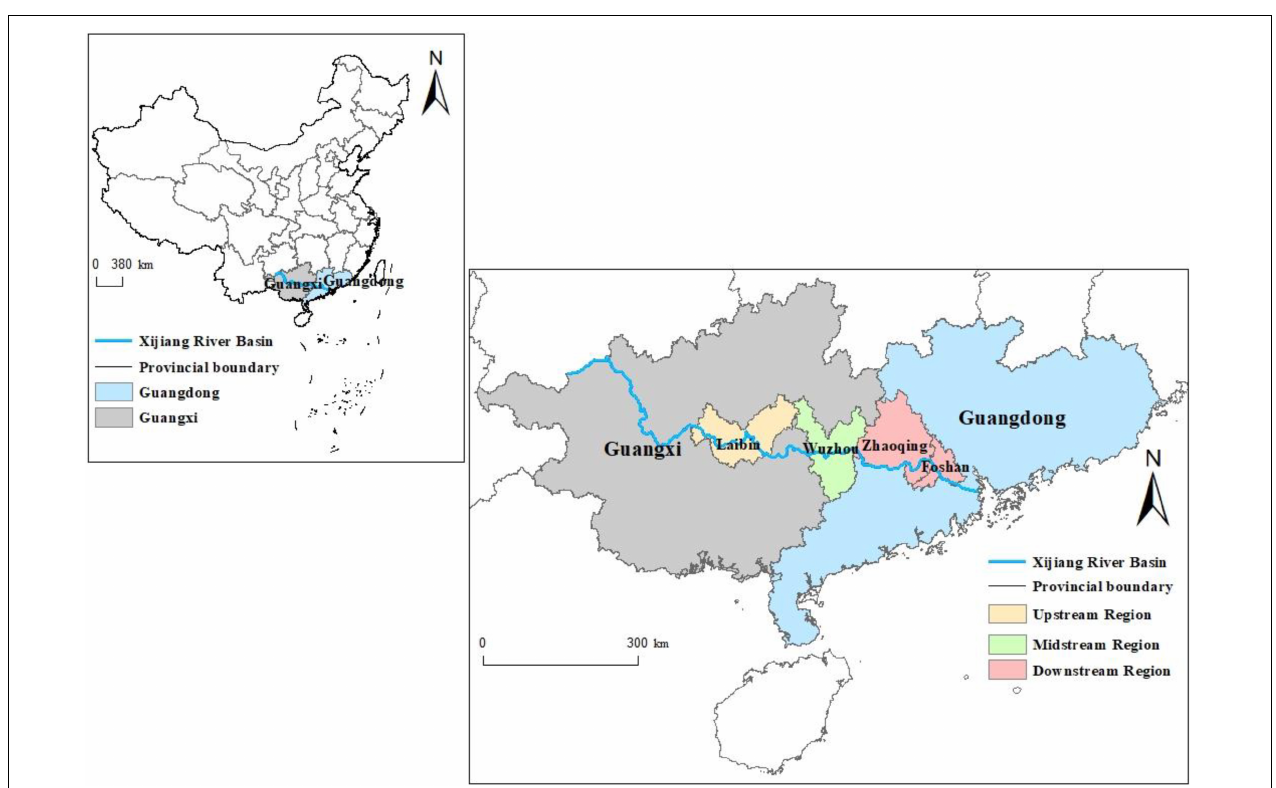
FIGURE 2 | The study